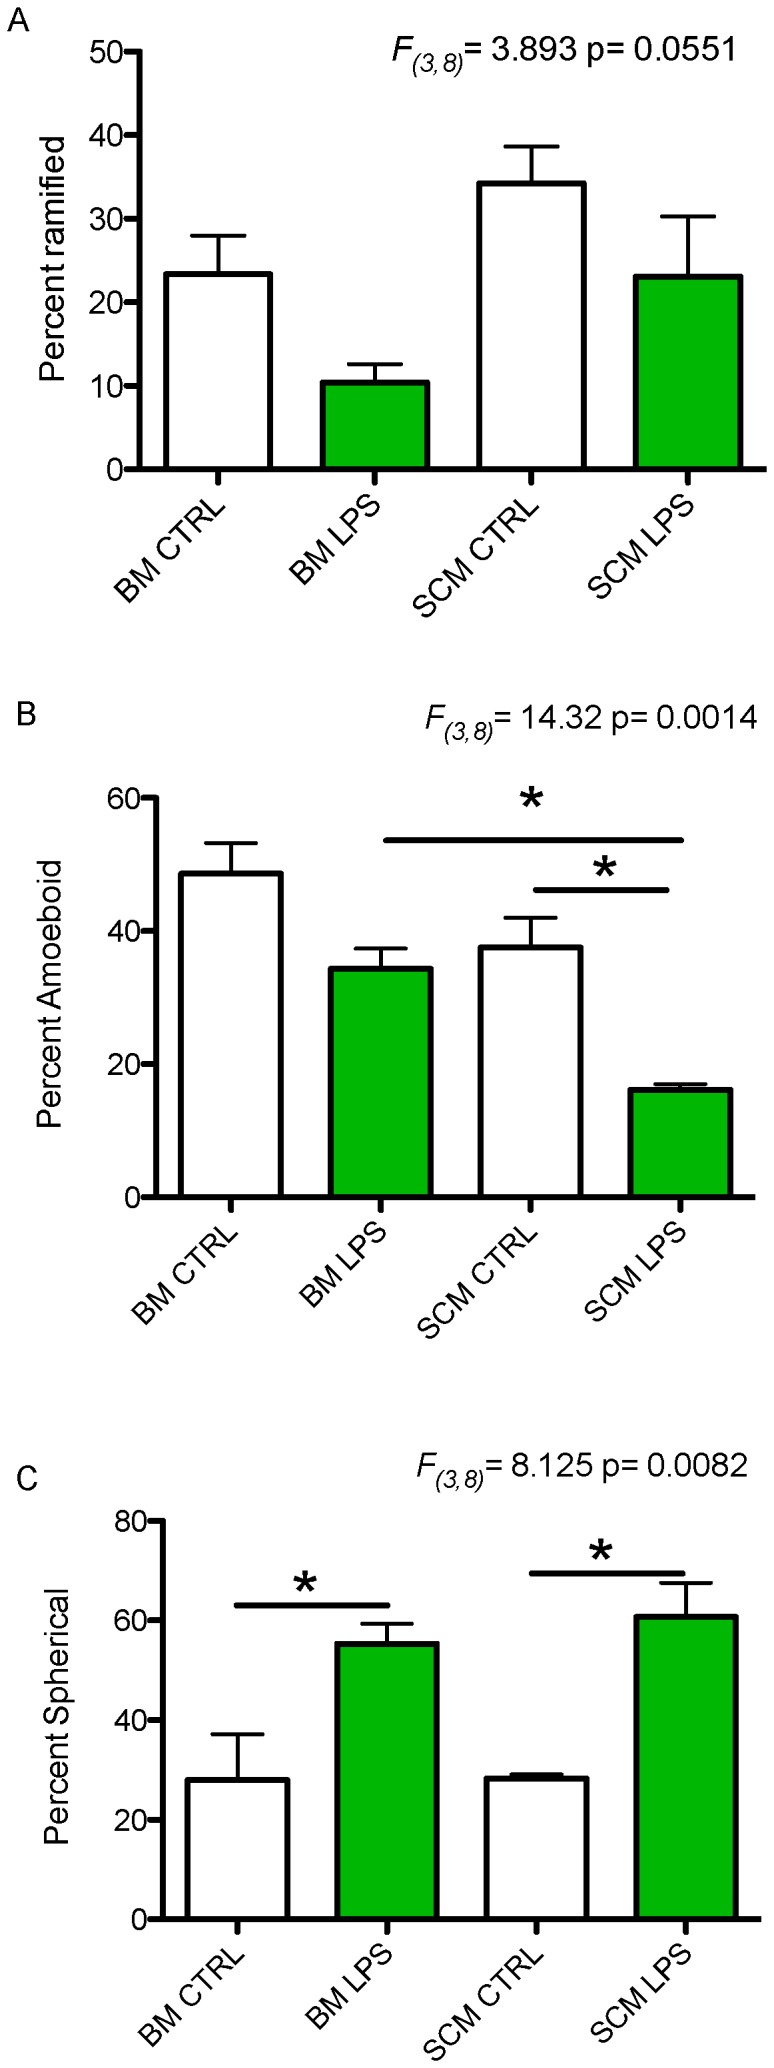
LPS mediated changes in morphology of SCM and BM.BM and SCM were activated with LPS to compare the differences in ramified, amoeboid and spherical morphologies. (A) A main effect of treatment group (BM control, BM LPS, SCM control, or SCM LPS) on the proportion of microglia with ramified morphology was not significant (ANOVA, F(3,8) = 3.893, p = 0.0551). (B) A significant main effect of treatment on the percentage of amoeboid cells was found (ANOVA, F(3,8) = 14.32, p = 0.0014). Notably, LPS activated SCM had significant lower percentage of amoeboid cells relative to SCM controls and LPS activated BM (Newman-Keuls post hoc test, n = 3, p<0.05). (C) Treatment significantly altered the percentage of spherical cells (ANOVA, F(3,8) = 8.125, p = 0.00821). LPS activated BM and SCM had a significant increase in spherical morphology relative to control conditions (Newman-Keul post hoc test, n = 3, p<0.05). n represents the number of independent experiment with a minimum of three replicates. Bars represent percent morphology of cell ± s.e.m.